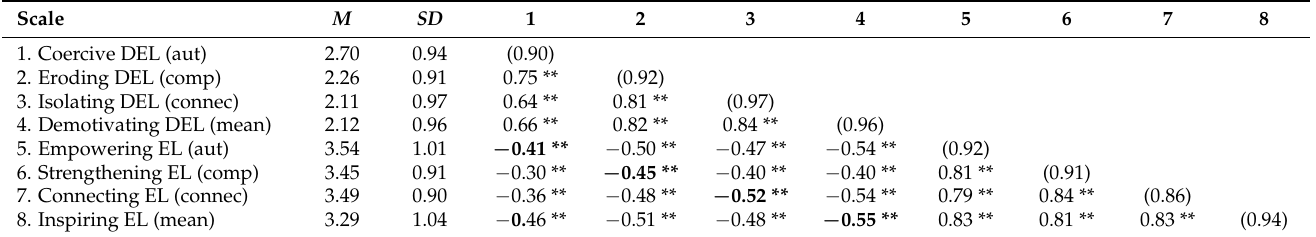
Table 4. Means, Standard Deviations, Intercorrelations, and Reliabilities (in Parentheses) of the Disengaging and Engaging Leadership dimensions ( N =